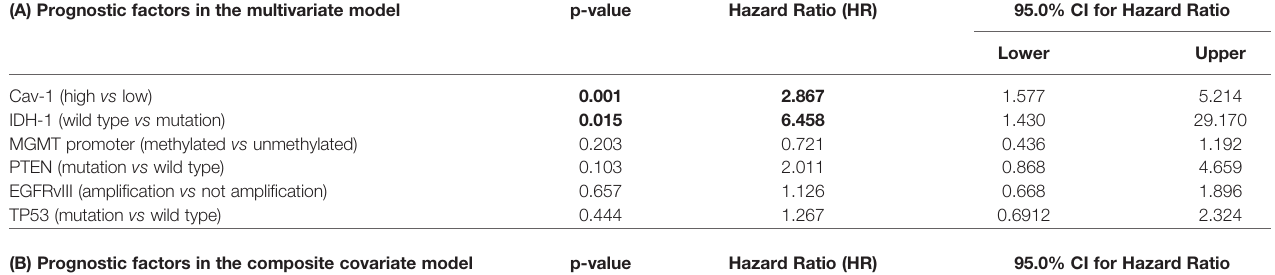
(B) Prognostic factors in the composite covariate model